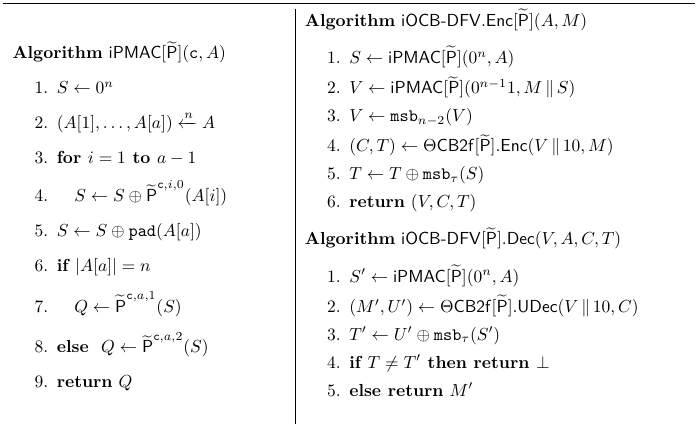
Figure 11: TURP-based idealization of OCB-DFV [ P ], iOCB-DFV [ e P